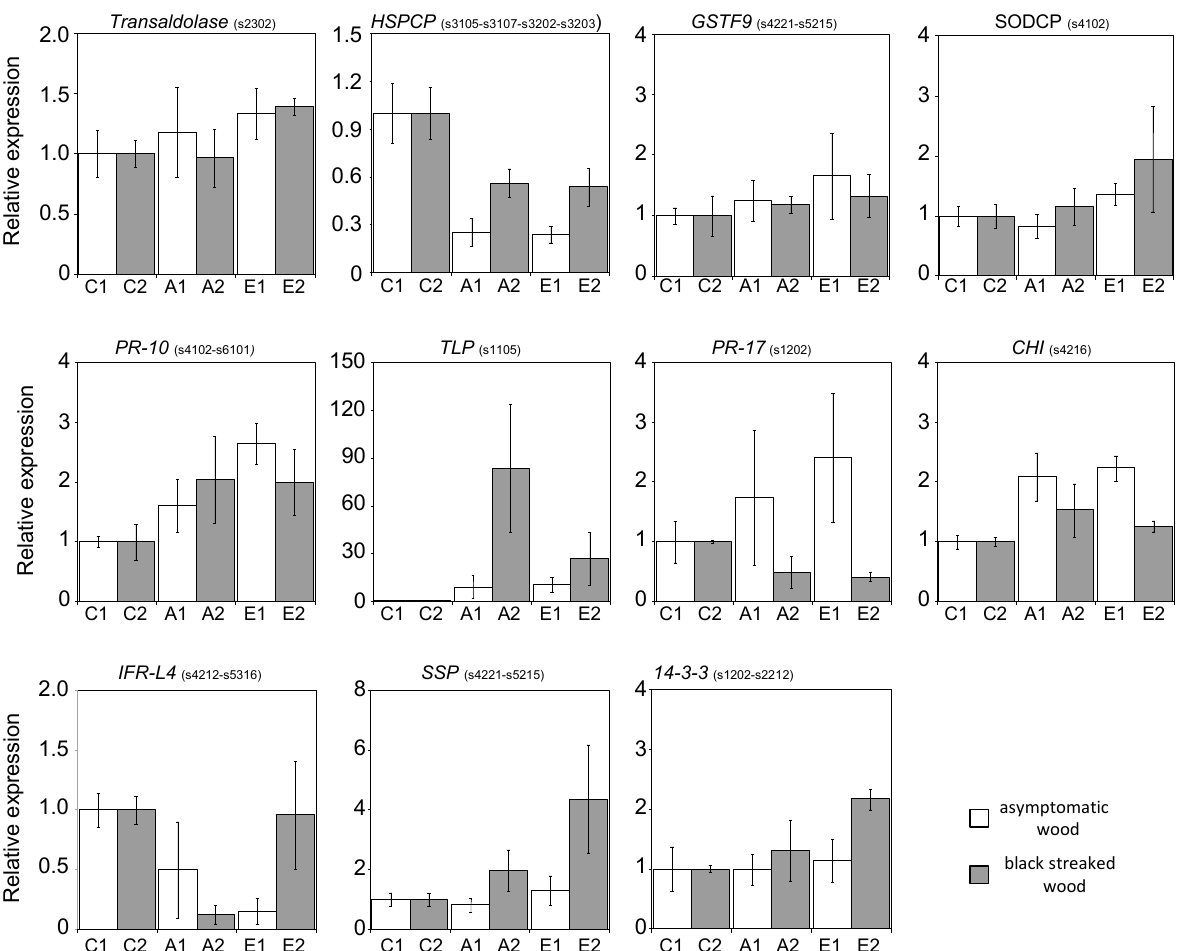
Figure 5. Expression levels of eleven selected genes in asymptomatic (C1, A1 and E1) and black streaked trunk wood (C2, A2 and E2) of control (C), apoplectic (A) and esca proper affected (E) 26 year-old standing grapevines (cv. Chardonnay) by quantitative reverse-transcription polymerase chain reaction. Results correspond to means (± standard deviation) of three independent experiences (C1, C2, A1, A2, E1 and E2). Gene expression was considered as significantly up- or down- regulated to the 1×controls, when changes in relative expression were > 2× or < 0.5×,